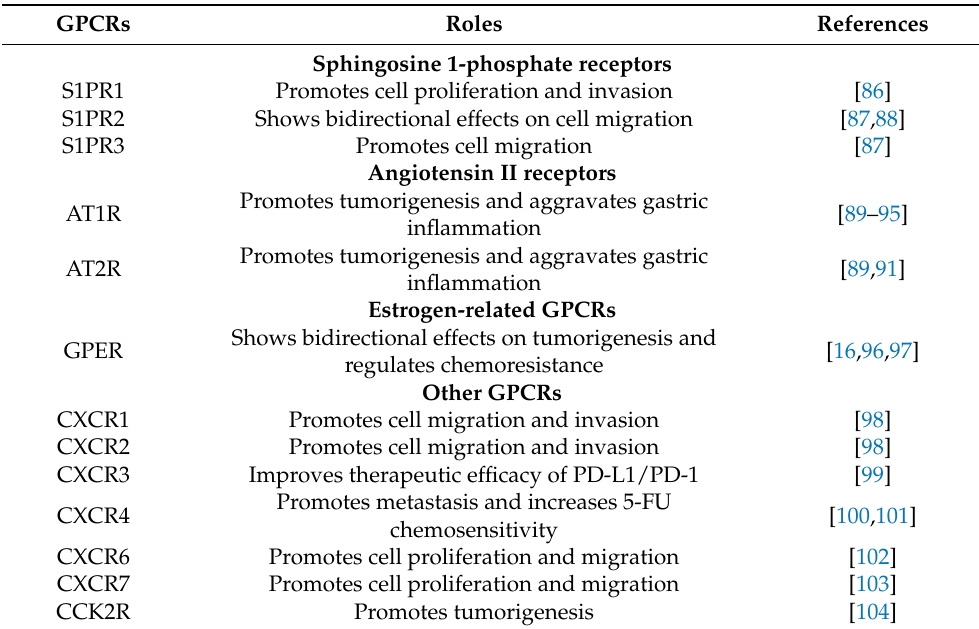
Table 2. Roles of G protein-coupled receptors in gastric